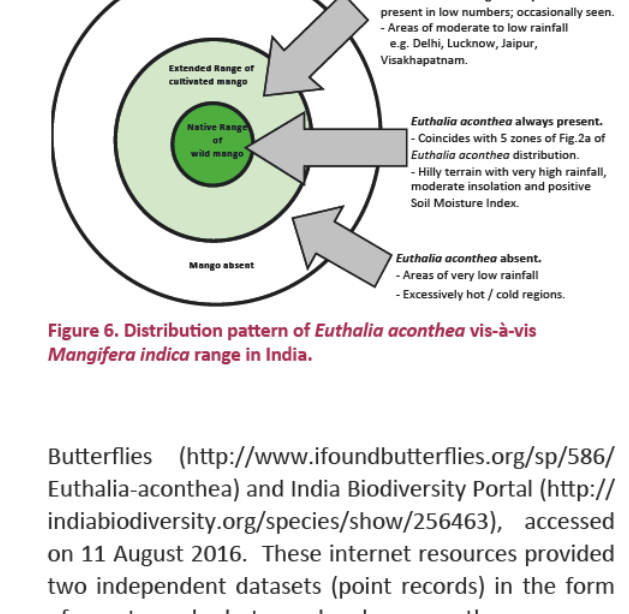
Ffigure 6. Dfisttrfibufion pattern of Eutthalfia acontthea vfis-à-vfis Mangfifera findfica range fin Indfia. Ffig 6. Dfisttrfibuttfion pattttern of Eutthalfia acontthea vfis-à-vfis Mangfifera findfica range fin